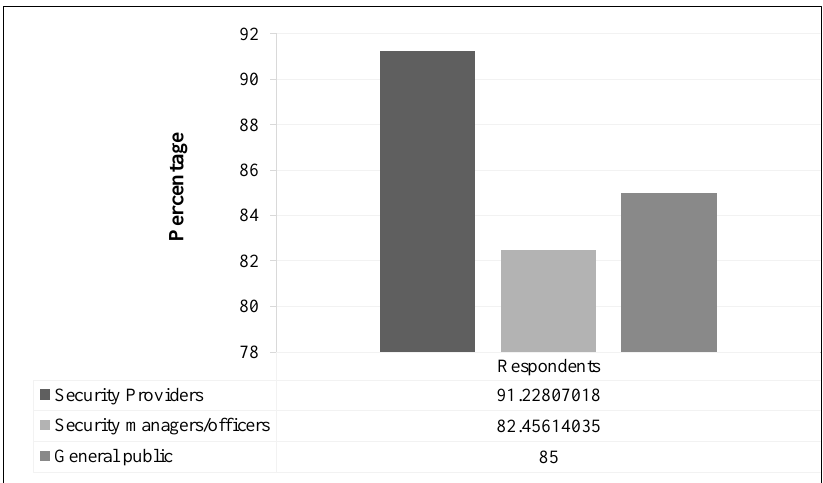
Figure 1. Commercial security effect in private functions and